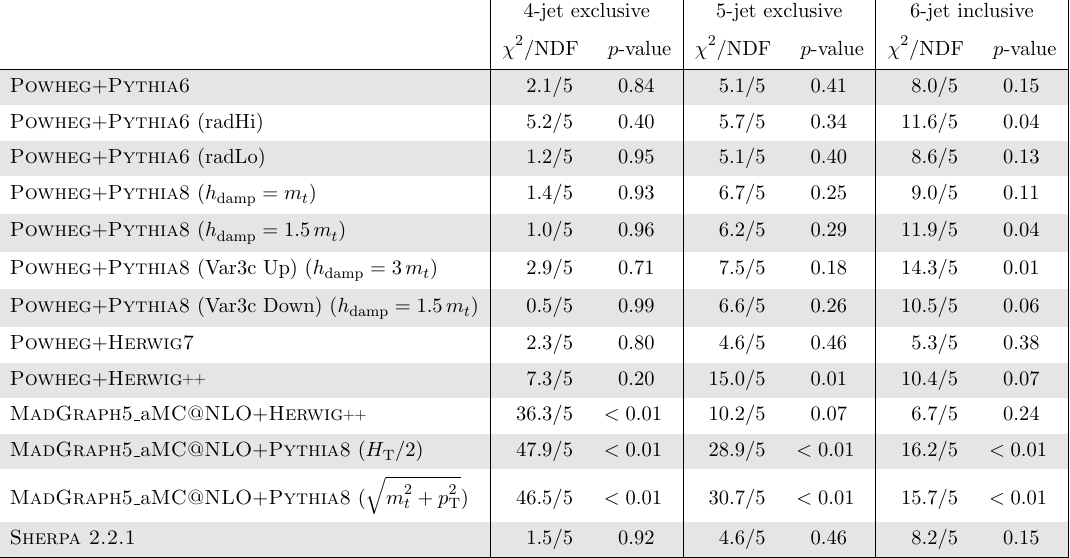
Table 8 . Comparison of the measured (cid:12)ducial phase space normalised di(cid:11)erential cross sections as (cid:12) (cid:12) (cid:12) (cid:12) a function of p t (cid:22) t and the predictions from several MC generators in di(cid:11)erent n -jet con(cid:12)gurations. out (cid:12) (cid:12) For each prediction a (cid:31) 2 and a p -value are calculated using the covariance matrix of the measured spectrum. The number of degrees of freedom (NDF) is equal to the number of bins in the distribution minus